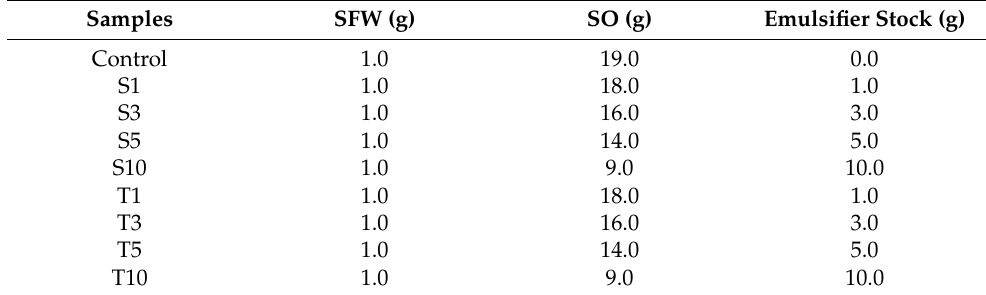
Table 5. Composition of prepared